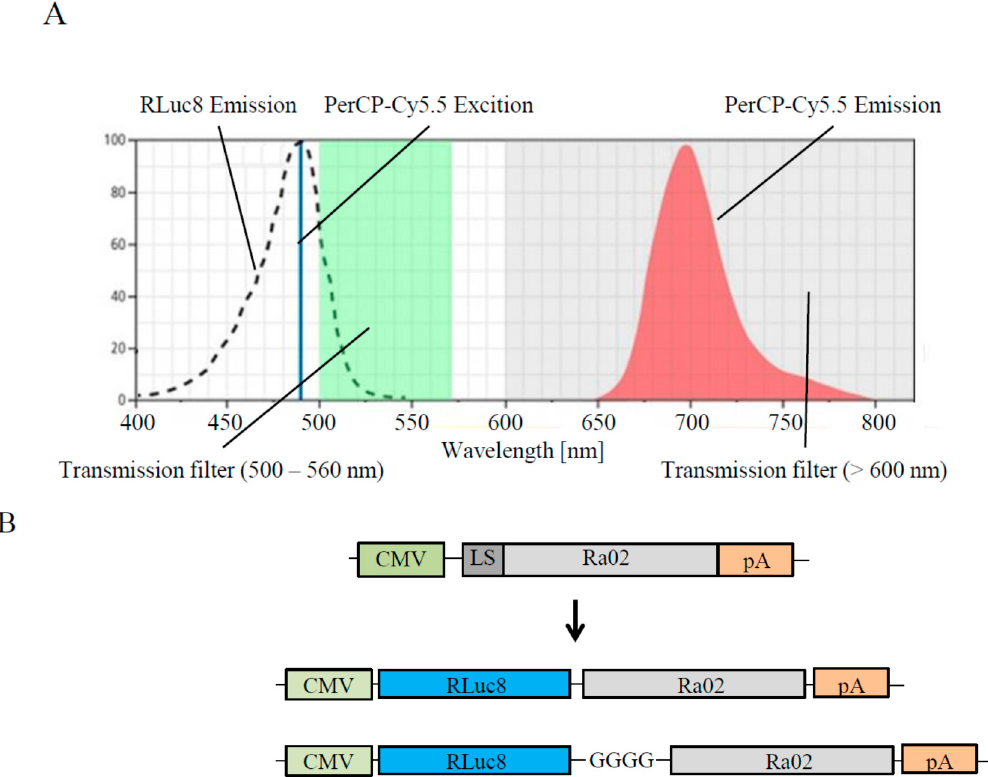
Figure 1. Schematic representation of the BRET principle and expression constructs. ( A ) RLuc8 converting n-CLZ and thus generating an emission peak (~490 nm) overlapping the excitation peak of PerCp-Cy5.5 ® , transferring energy to the fluorophore which is emitting light at ~700 nm; ( B ) BRET donor expression construct containing the luciferase RLuc8 and the VEGF binding domain Ra02 fused directly or separated with a 4× glycine peptide-linker, under the control of a CMV (cytomegalovirus) promoter and a polyadenylation signal (pA) sequence at the 3´-end.